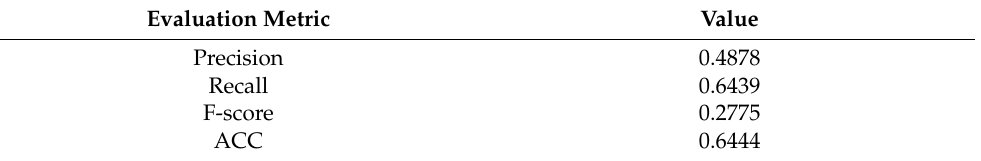
Table 7. Final model evaluation